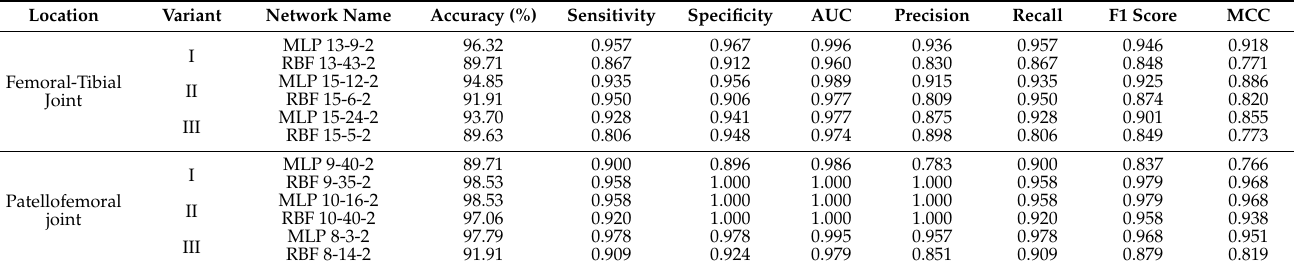
Table 5. Comparison of diagnostic results for different anatomical locations for all